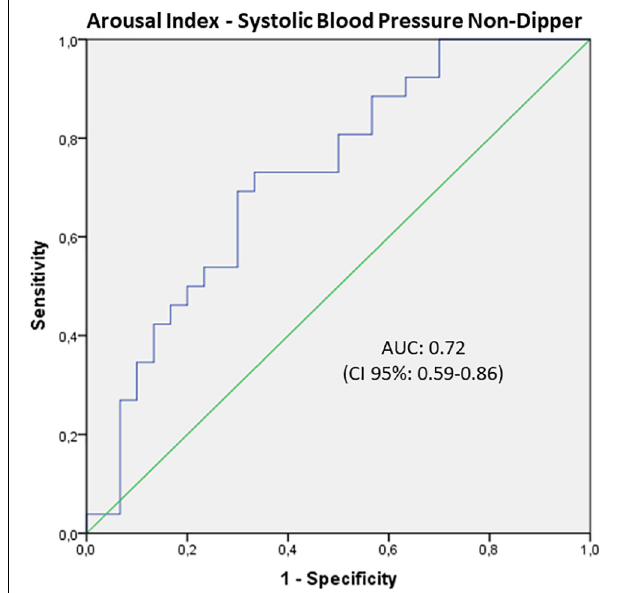
FIGURE 2 | ROC curve of the arousal index to separate dipping and non-dipping systolic blood pressure (SBP). There was an acceptable discrimination by the AUC of 0.72 (95%CI: 0.59–0.86), which indicates that sleep fragmentation can be used to identify patients with non-dipping blood pressure and therefore cardiovascular